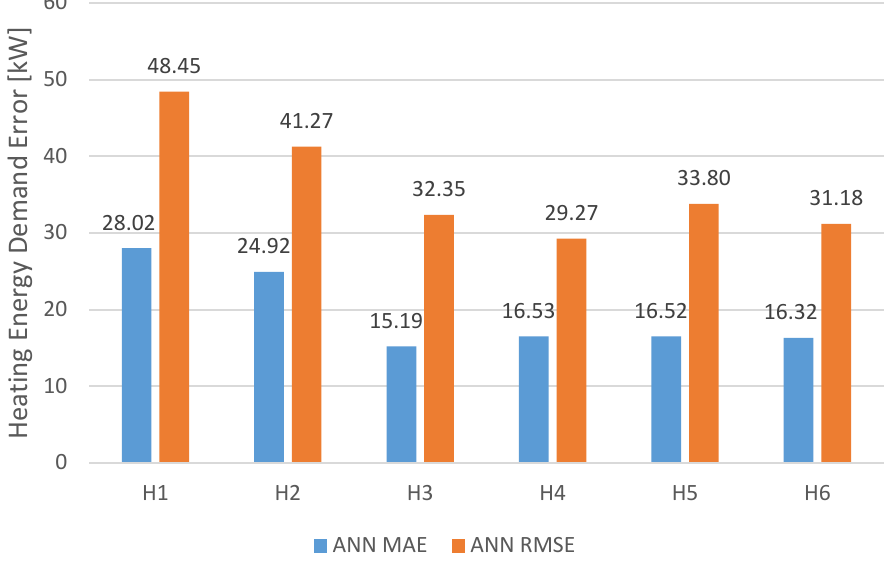
Figure 6. Error metrics for heating energy demand using ANN.